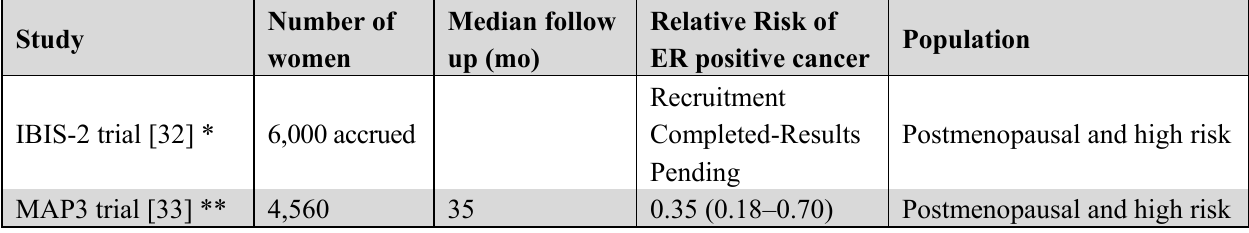
Table 4. Studies on AIs as a breast cancer preventive